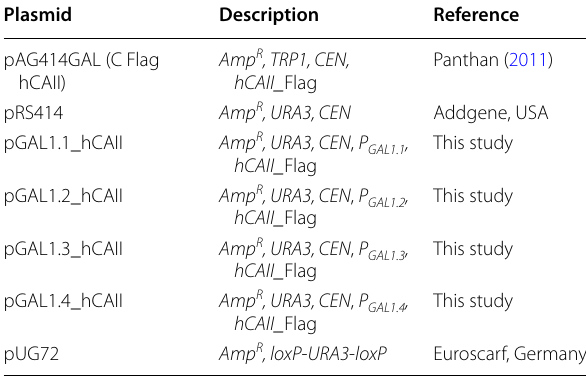
Table 2 Plasmids used in this